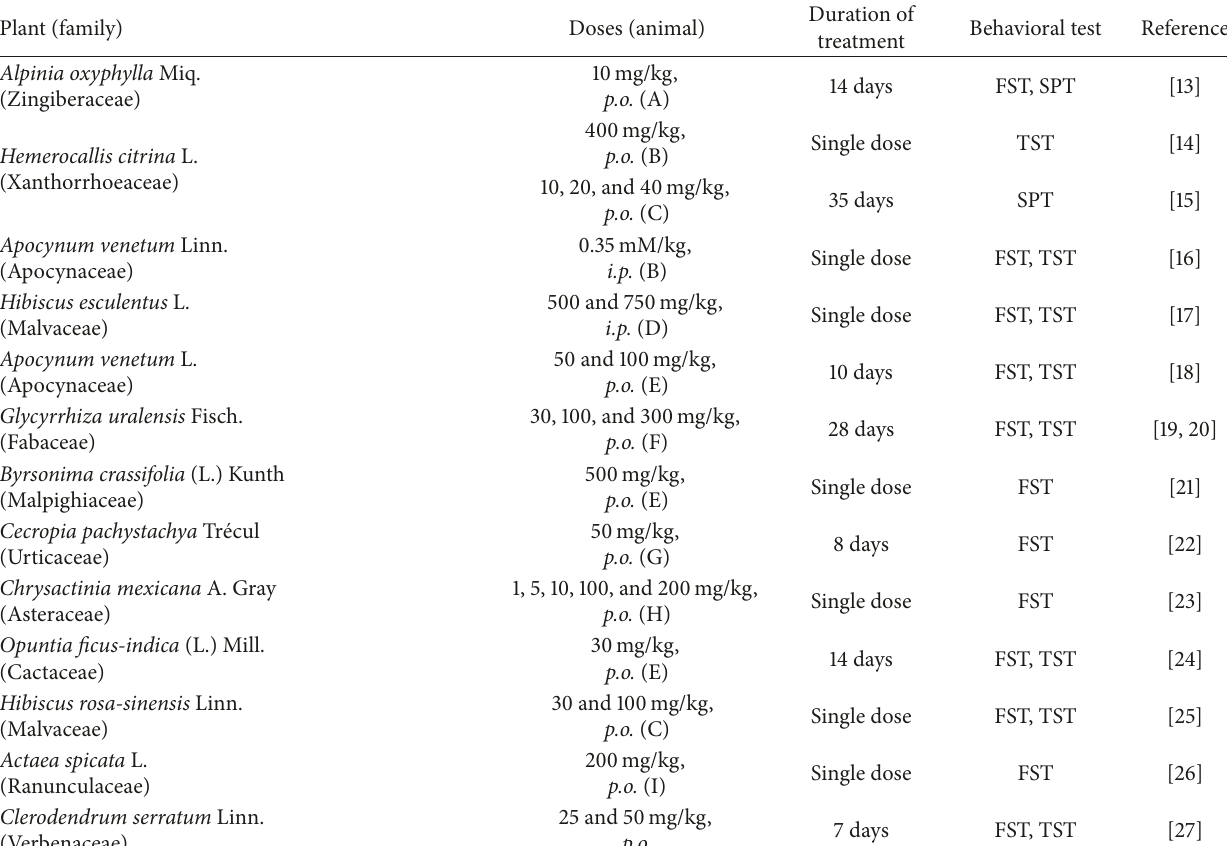
Table 1: Plants with antidepressant-like effects associated with their total flavonoids content. Plant